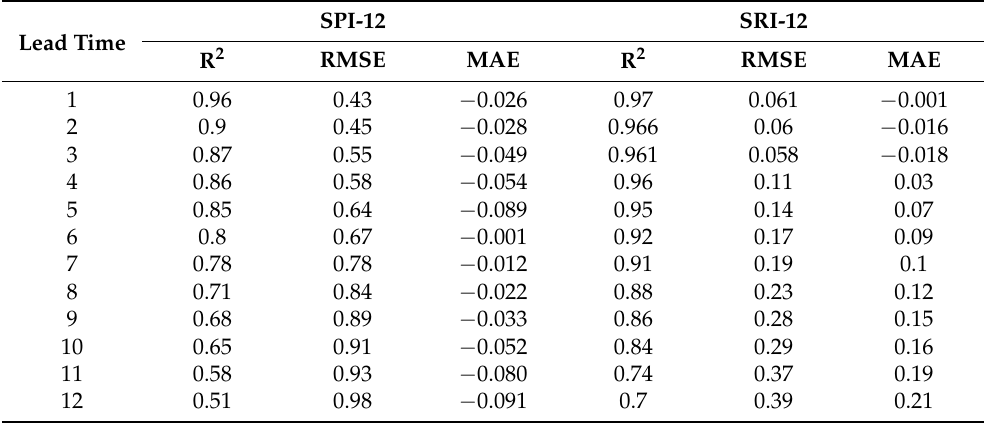
Table 5. Coefficient of correlation, RMSE, and MAE between observed and predicted data for lead time 1 to